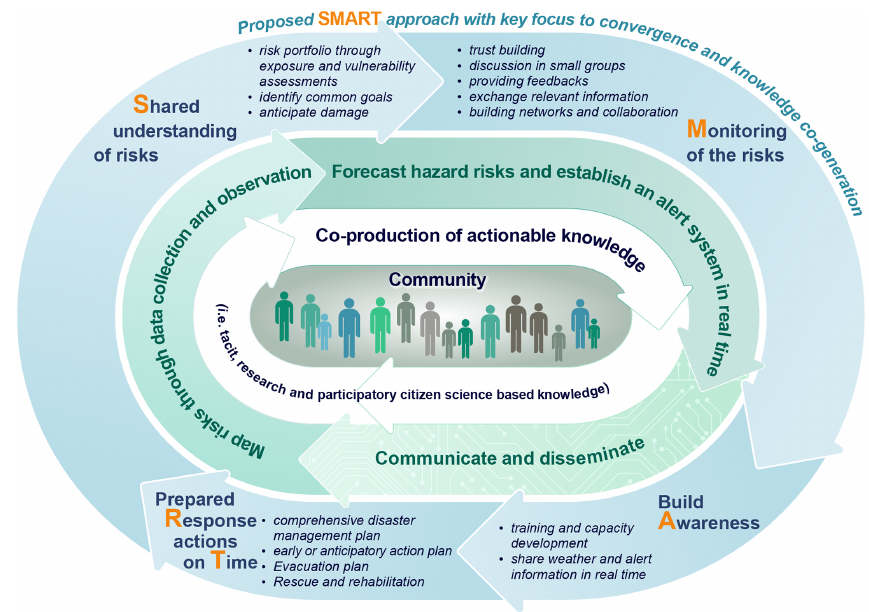
Figure 2. A SMART convergence research approach to ensure inclusiveness in designing monitoring and alert system to provide early warning information to minimise disaster